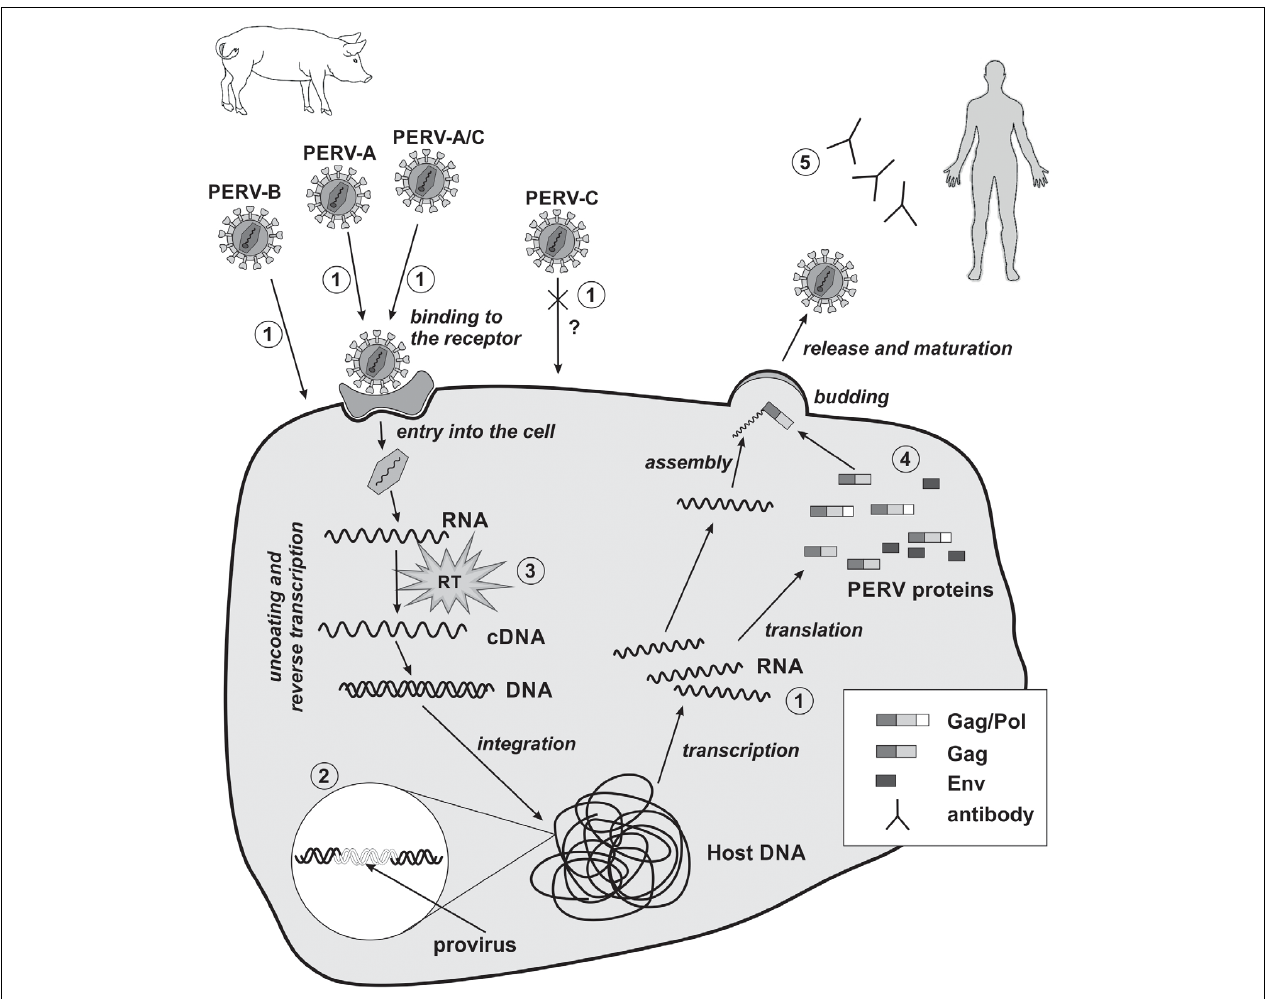
FIGURE 2 | Replication cycle of PERV and strategies of PERV detection in xenotransplantation. 1, detection of viral RNA; 2, detection of viral DNA; 3, evaluation of reverse transcriptase activity; 4, detection of PERVs proteins; 5, detection of PERVs antibodies. RT, reverse transcriptase; cross and question mark, PERV-C there is no body of evidence for the possibility of human cells infection in vivo